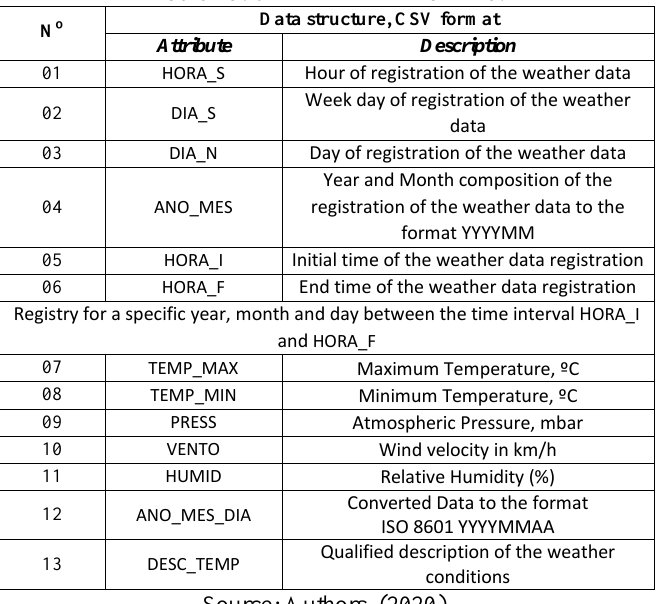
Table 15: CLIMA E TEMPO – RJ.